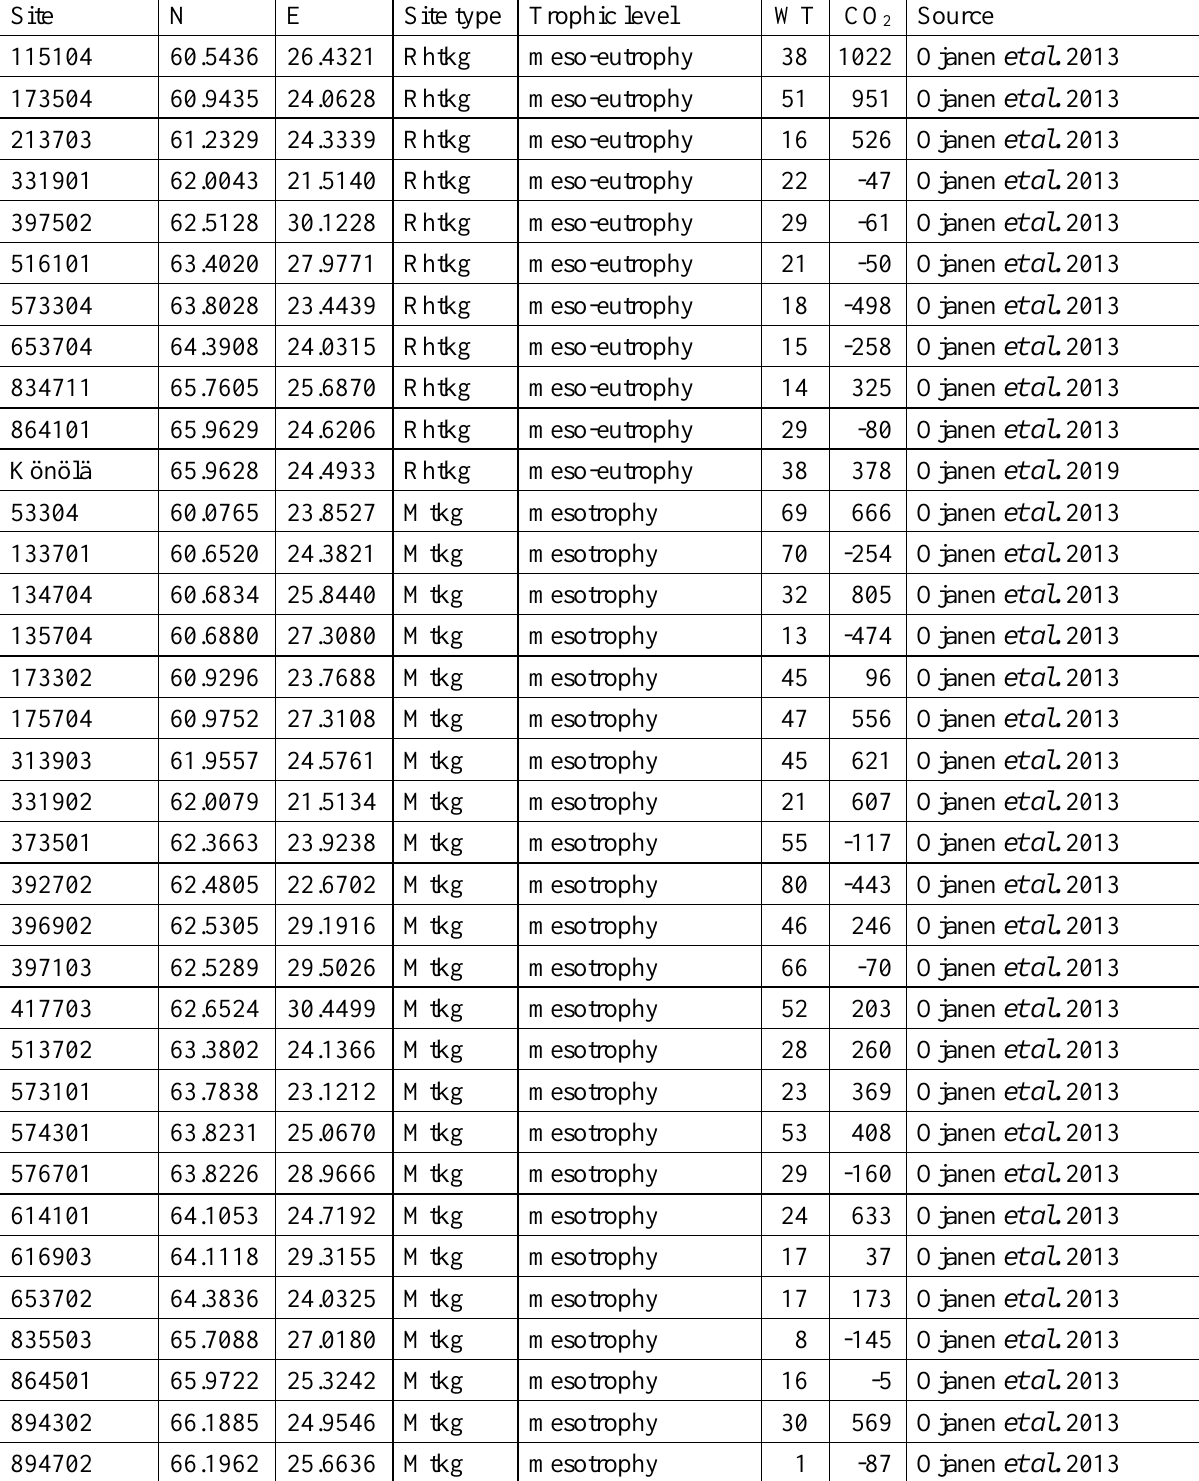
Table A1. Study sites, their coordinates (ETRS89/WGS84), site types (Laine et al. 2012), trophic levels, mean Key to site types: Rhtkg = Herb-rich type, Mtkg = Vaccinium myrtillus type, Ptkg = Vaccinium vitis-idaea type, Vatkg = Dwarf shrub type, Jätkg = Cladina type. These data are also provided in Excel format, as supplementary